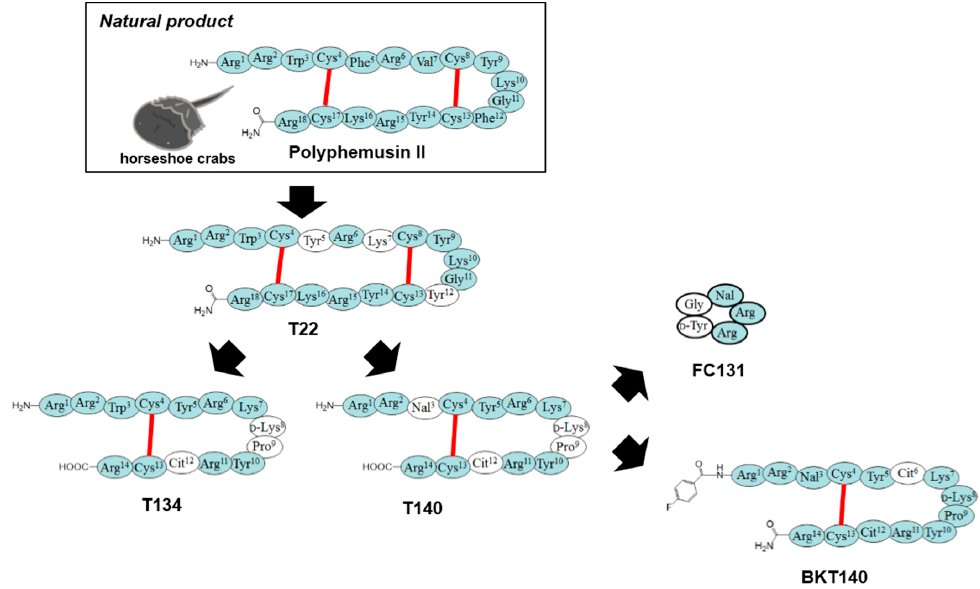
Figure 4. Discovery and development of C–X–C chemokine receptor type 4 (CXCR4) antagonists with potent anti-HIV activity from host-defense peptide of horseshoe crabs. Substitutions are highlighted in white. Red lines indicate intramolecular disulfide bond formation. Cit, L -citrulline; Nal, L -3-(2- naphthyl)alanine.